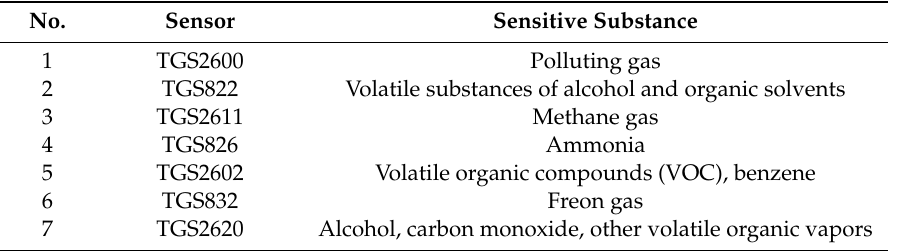
Table 1. Gas sensor information in E-nose